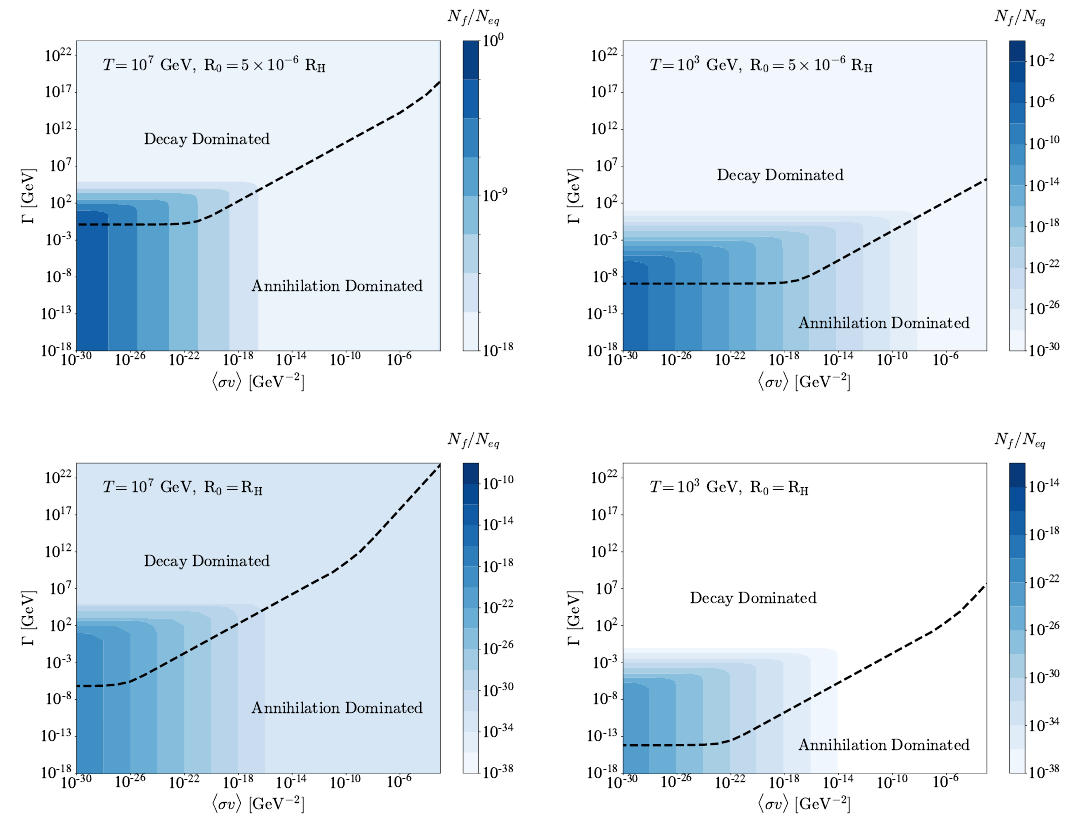
, for the same four χ